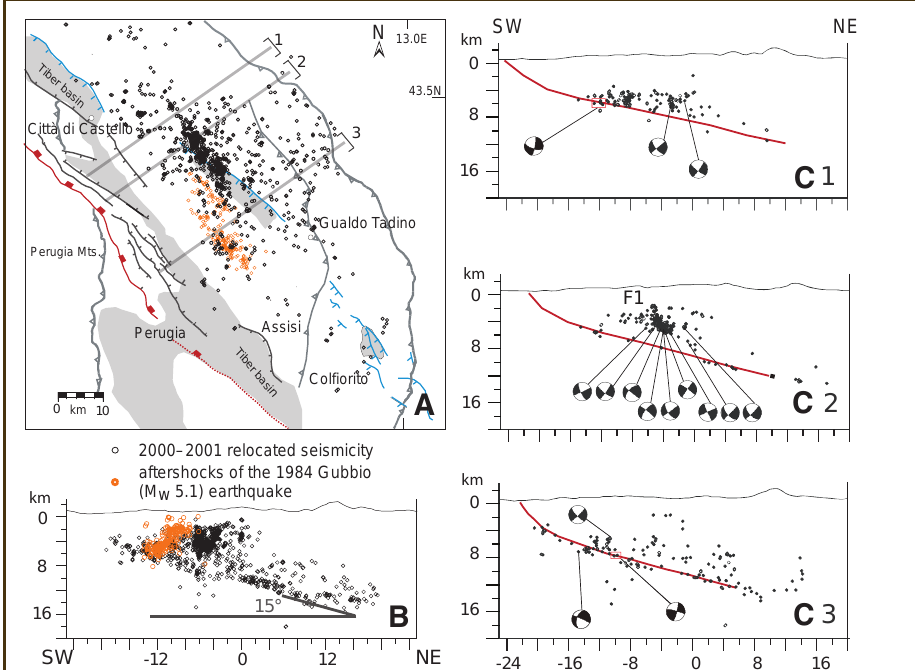
Figure 4. [A] Map of the area and location of seismic sections. [B] Vertical cross-section perpendicular to the Apenninic belt showing the relocated composite seismicity and (in orange) the 1984 Gubbio sequence. [C] Three vertical cross-sections showing the seismicity distribution and the available fault plane solutions computed for seismic data acquired from 2000 to 2001. Their positions are shown in [A] together with the width used to plot hypocenters. The heavy red lines plotted in each cross-section represent the trace of the ATF fault as imaged on the depth-converted seismic reflection profiles (modified from Chiaraluce et al.,